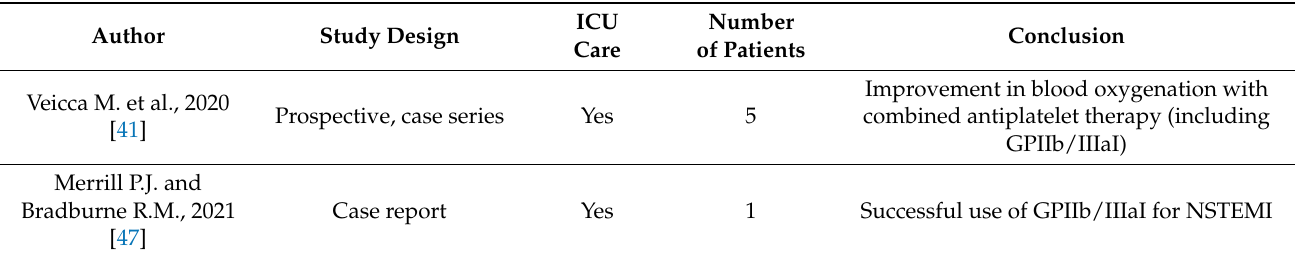
Table 3. GPIIb/IIIaI therapy in patients with